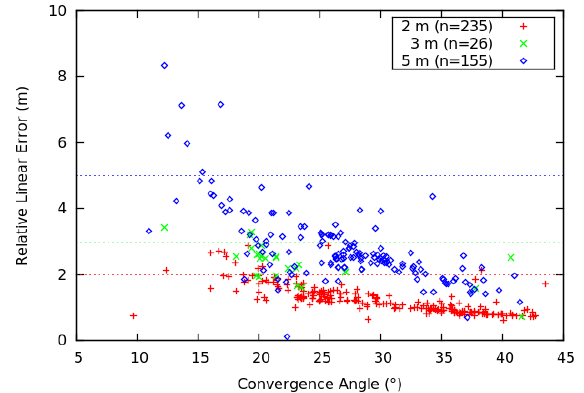
Figure 1. Convergence angle as a function of precision and DTM post spacing for all ASU NAC DTMs produced to date (n=417).